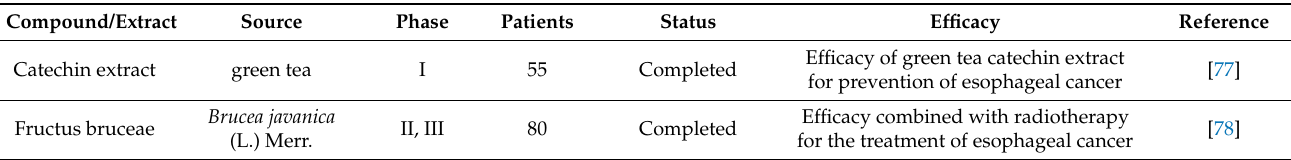
Table 5. Clinical